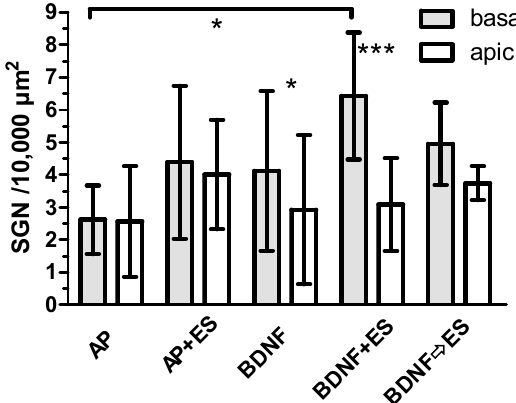
Figure 7. Comparison of the SGN density in basal and apical turns (mean ± SD). In BDNF and BDNF + ES groups, this difference was significant (asterisks above the respective bars). The number of SGN in the basal turn was increased compared to the AP group only in the BDNF + ES group, as indicated at the horizontal line. * p < 0.05; *** p < 0.001.